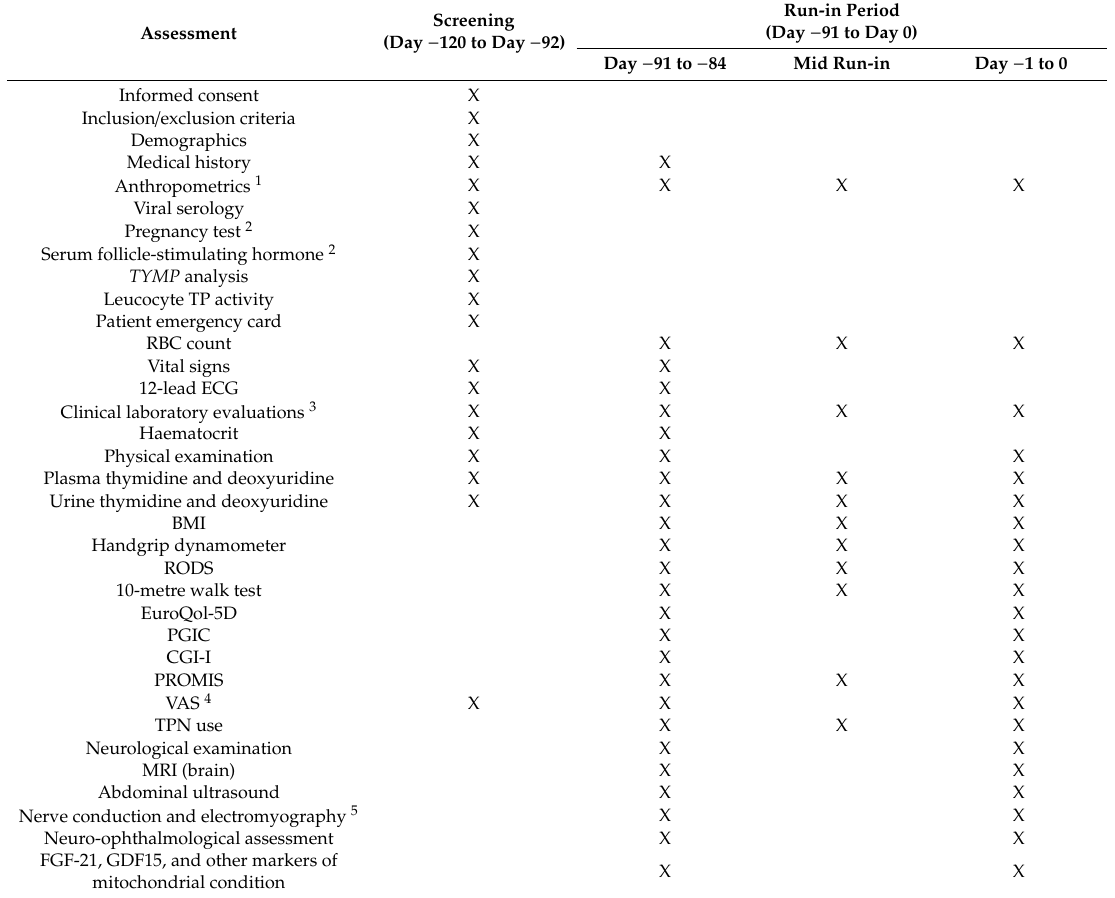
Table 3. Schedule of assessments from screening to the end of the run-in